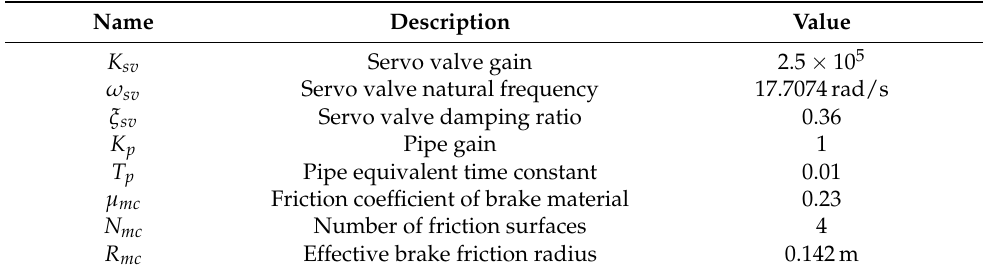
Table 6. Parameters of the hydraulic servo